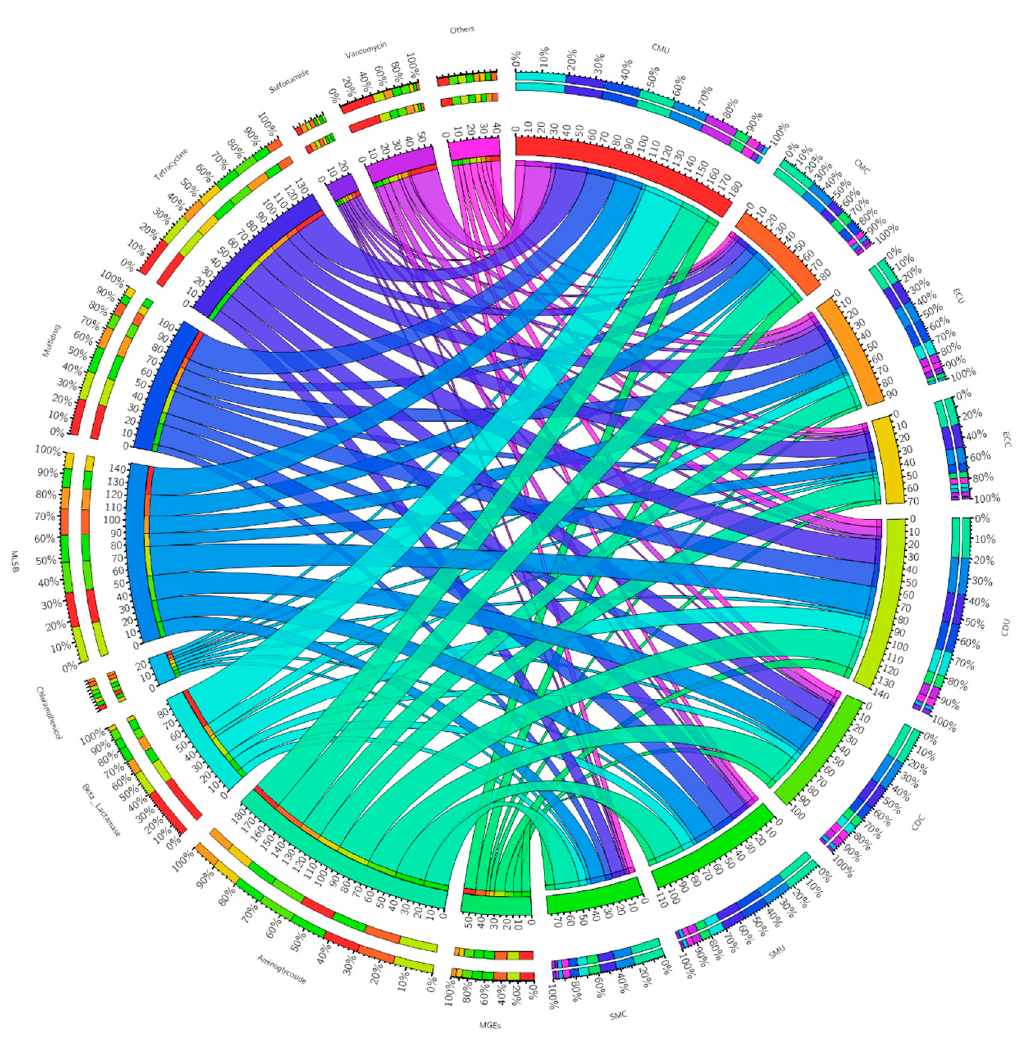
Figure 5. Distribution of each ARG type in eight organic fertilizer samples. The data were visualized via Circos software (http://circos.ca/). The length of the bars of each sample on the outer ring represents the percentage of ARGs in each sample.